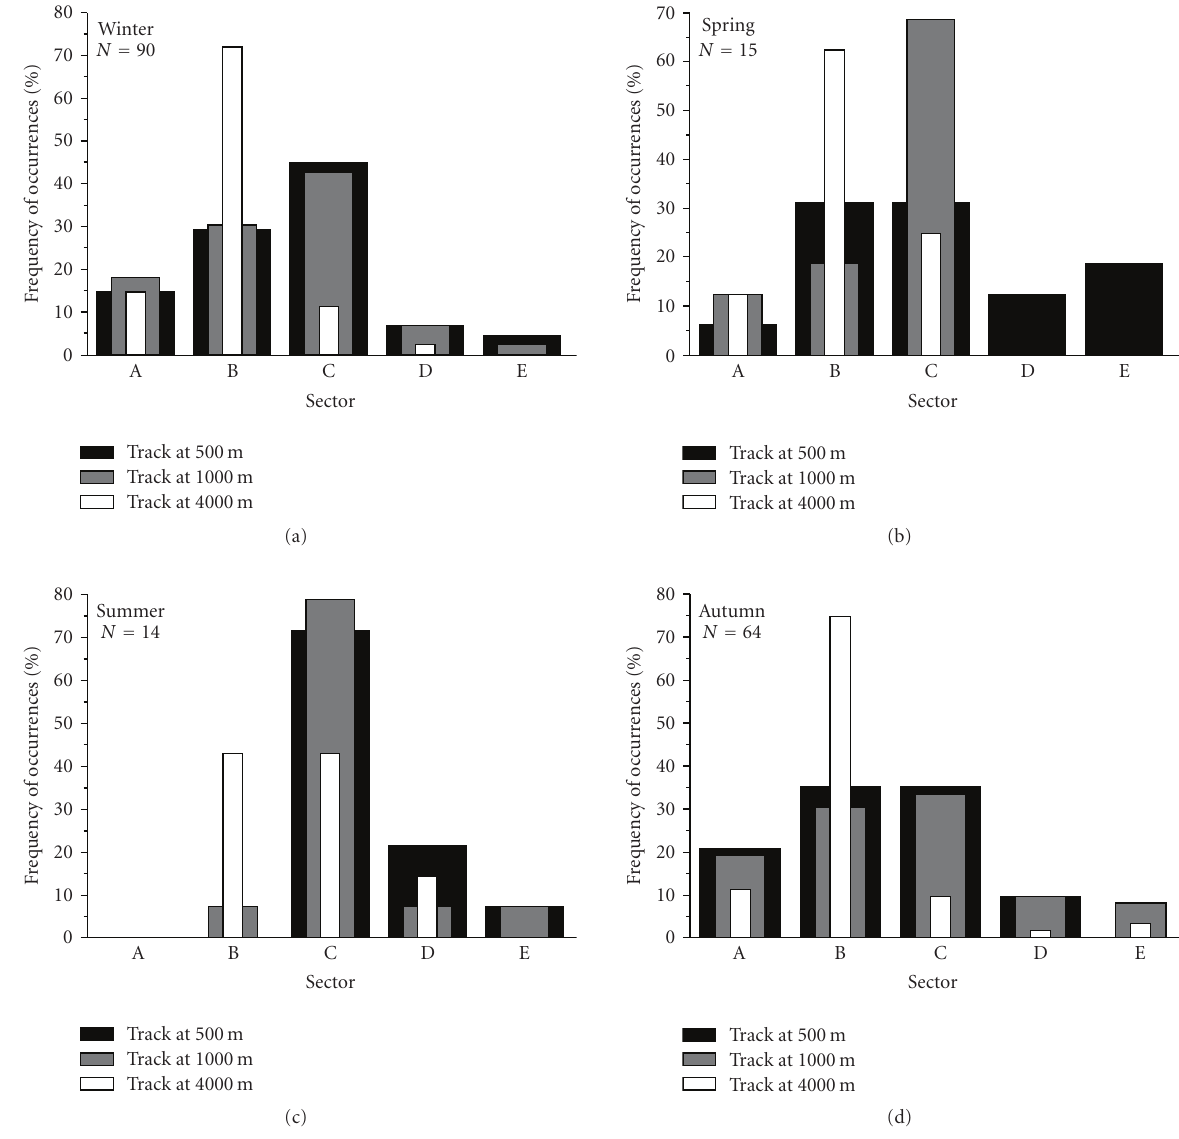
Figure 7: Same as in Figure 6, but for the CM aerosol